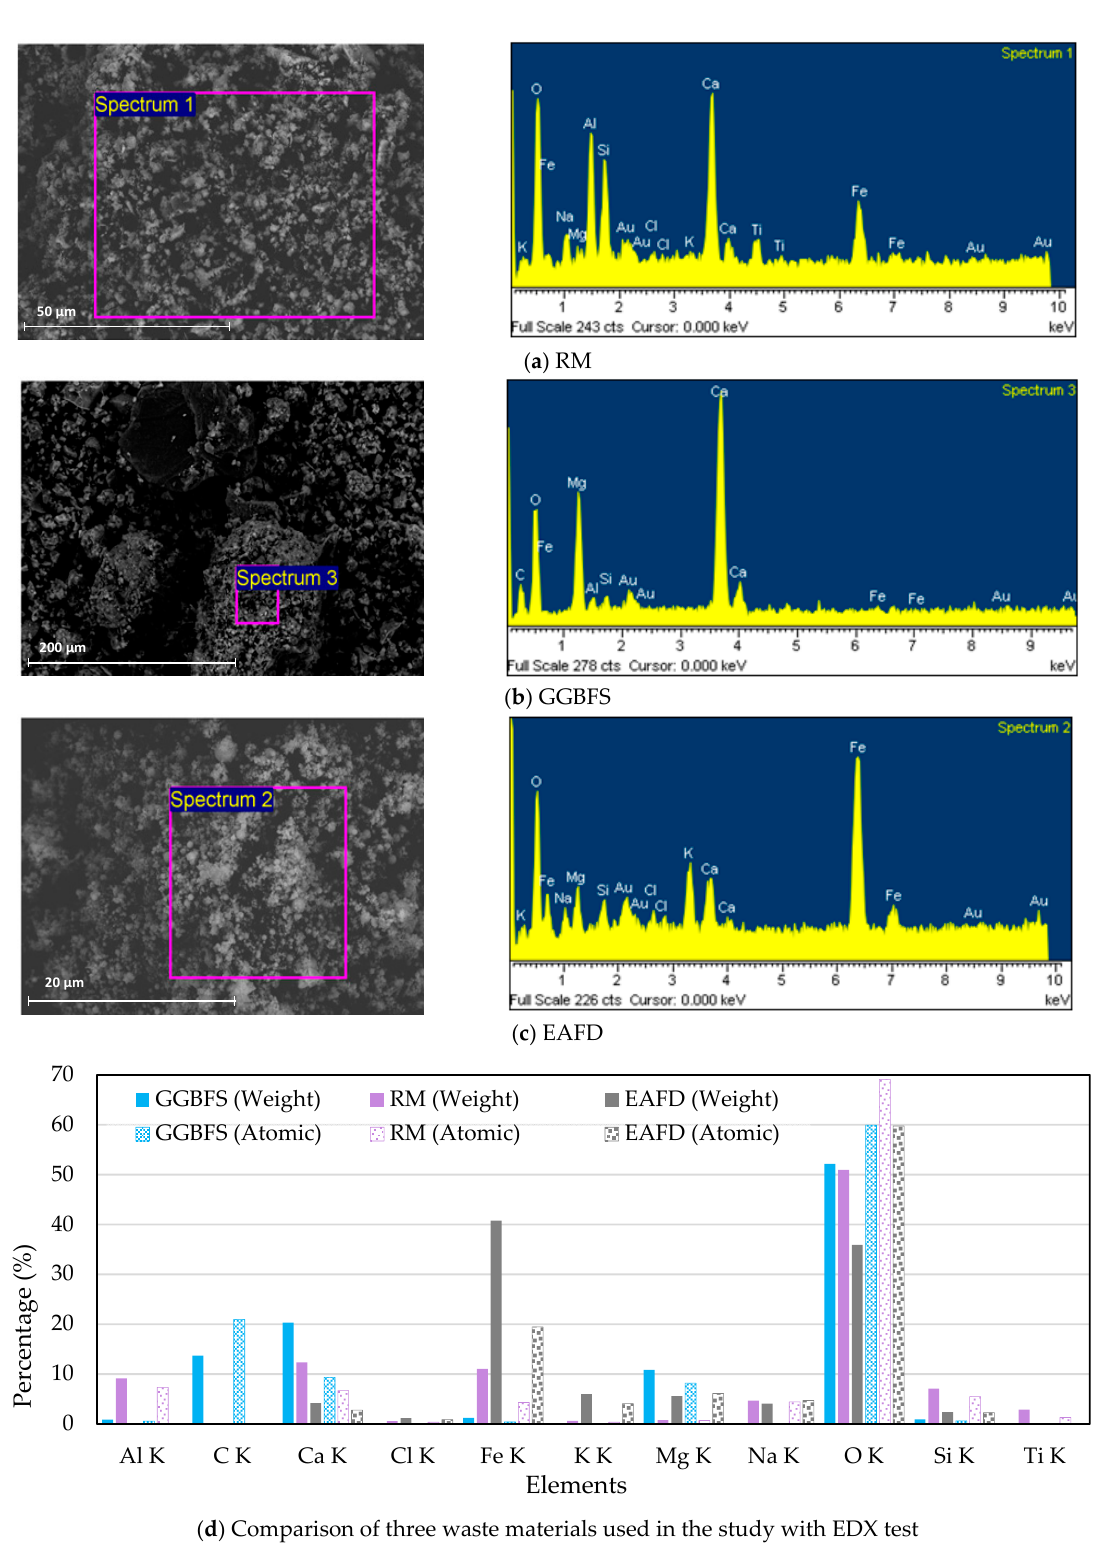
Figure 5. EDX analysis of waste powders.